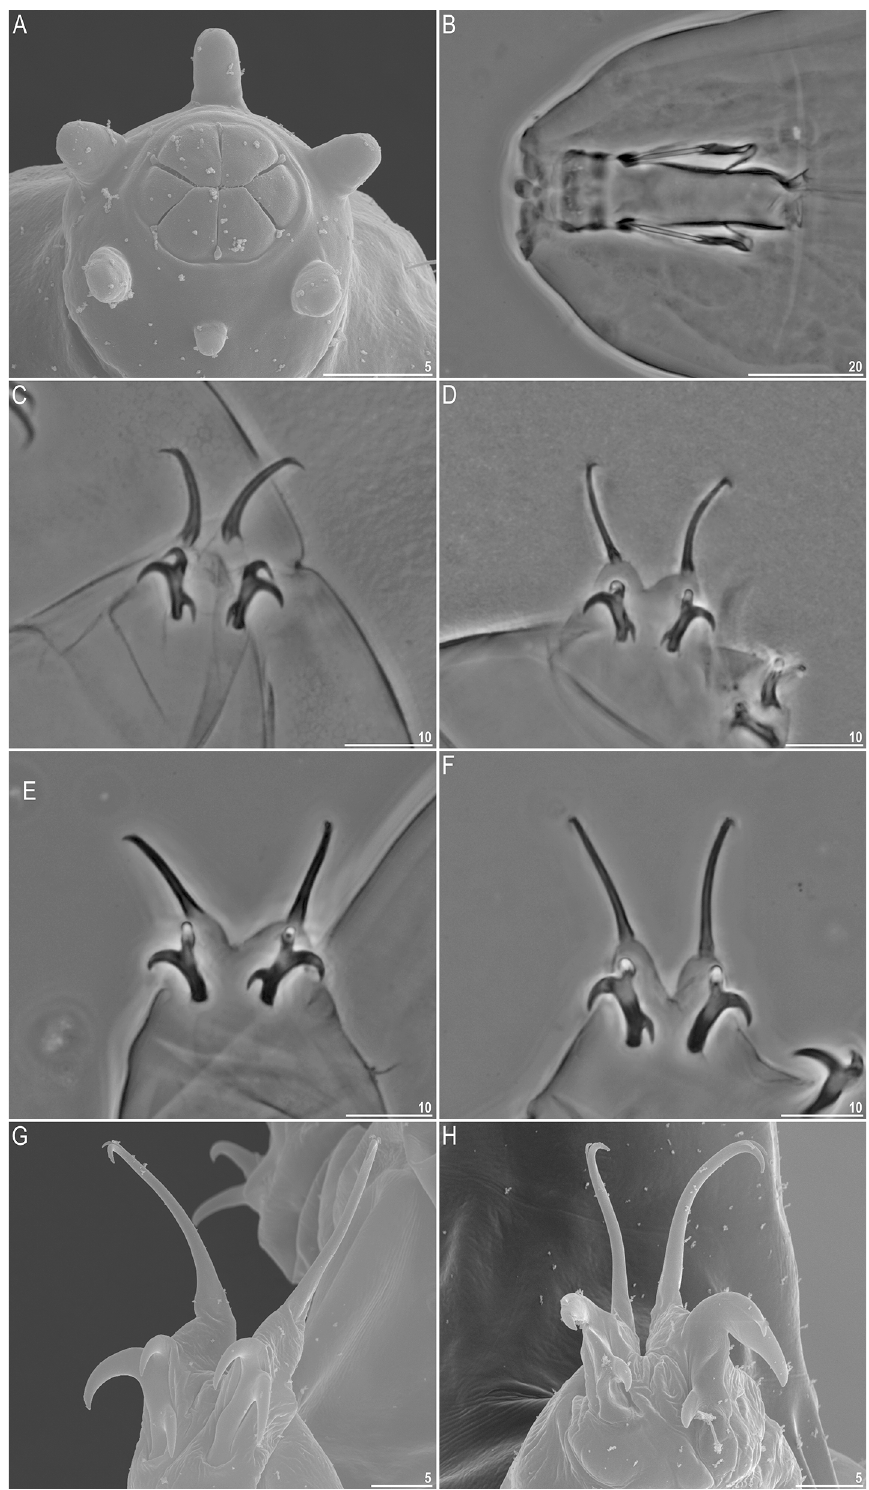
Figure 4. General morphology of Milnesium decorum sp. nov. ( A ) SEM photograph of mouth opening; with six, unequal in size peribuccal lamellae, so called 4 + 2 configuration (paratype); ( B ) buccal apparatus, PCM (holotype); ( C ) claws III of the hatchling, with the [3-3] CC, PCM (paratype); ( D ) claws IV of the hatchling, with the [3-3] CC, PCM (paratype). ( E ) claws III of the juvenile, with the [2-3] CC, PCM (holotype); ( F ) claws IV of the juvenile, with the [3-2] CC, PCM (holotype); ( G ) claws III of the female, with the [3-2] CC, SEM (paratype); ( H ) claws I of the male, with the secondary branches modified into rigid hooks and absent cuticular bars, SEM (paratype). All scale bars in